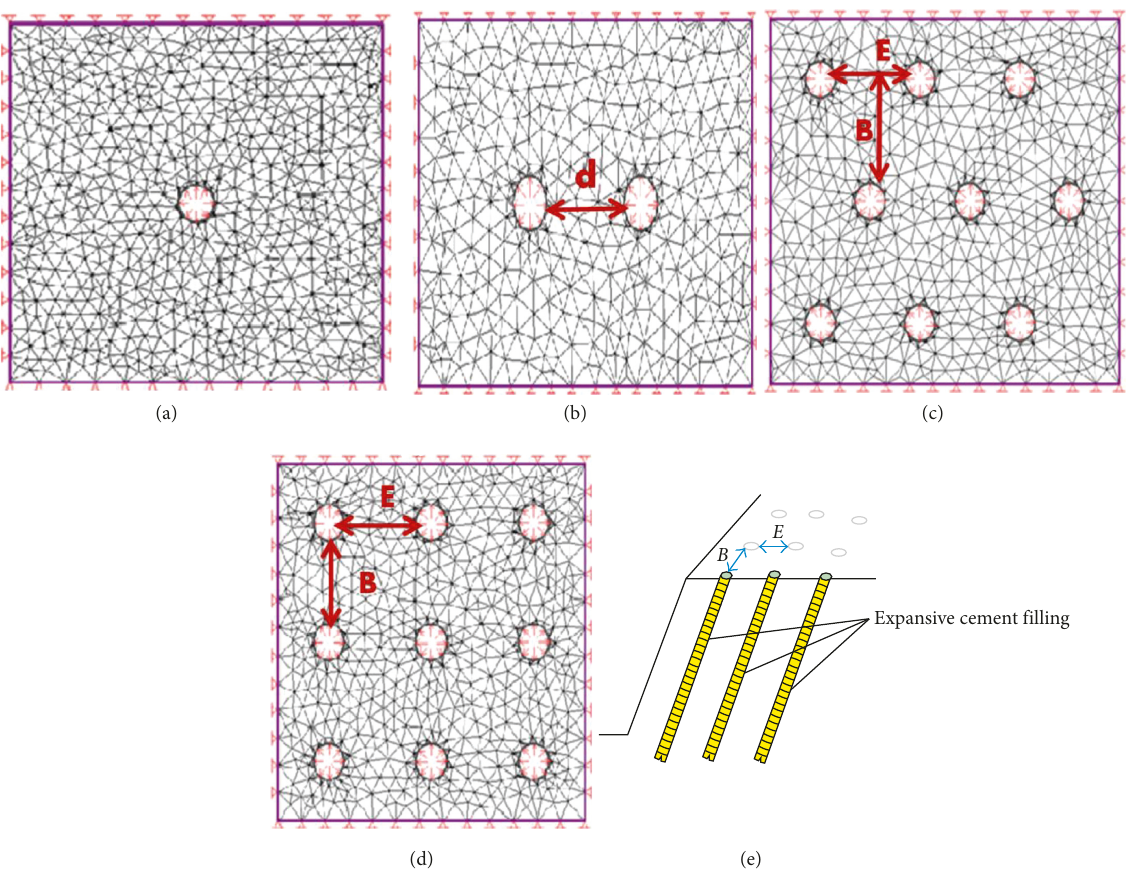
Figure 3: Presentation of the models